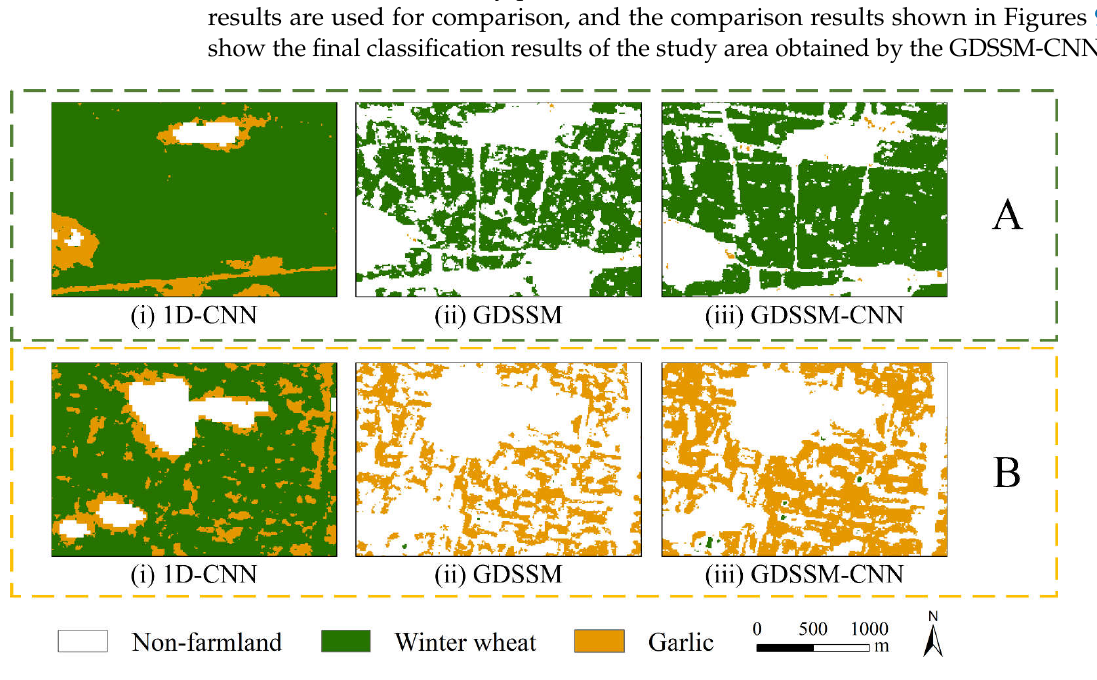
Table 2. Accuracy evaluation for different classifiers.